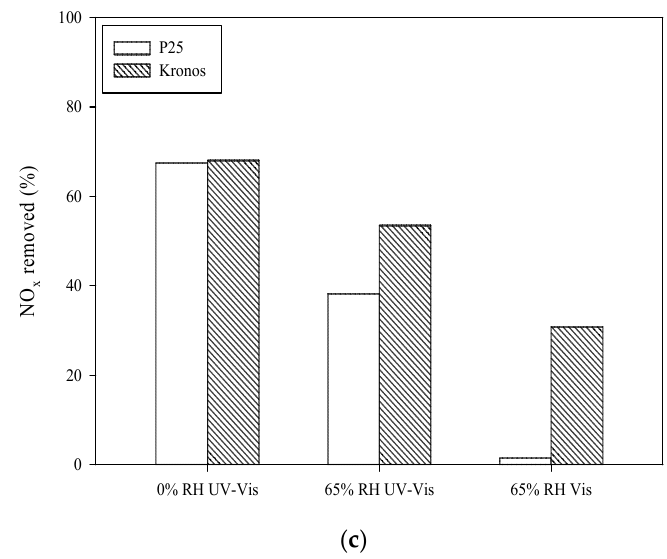
Figure 5. NOx removed with mortars with photoactive surface layer after 28 days: with sand ( a ), without sand ( b ), comparison of P25-Kronos ( c ).